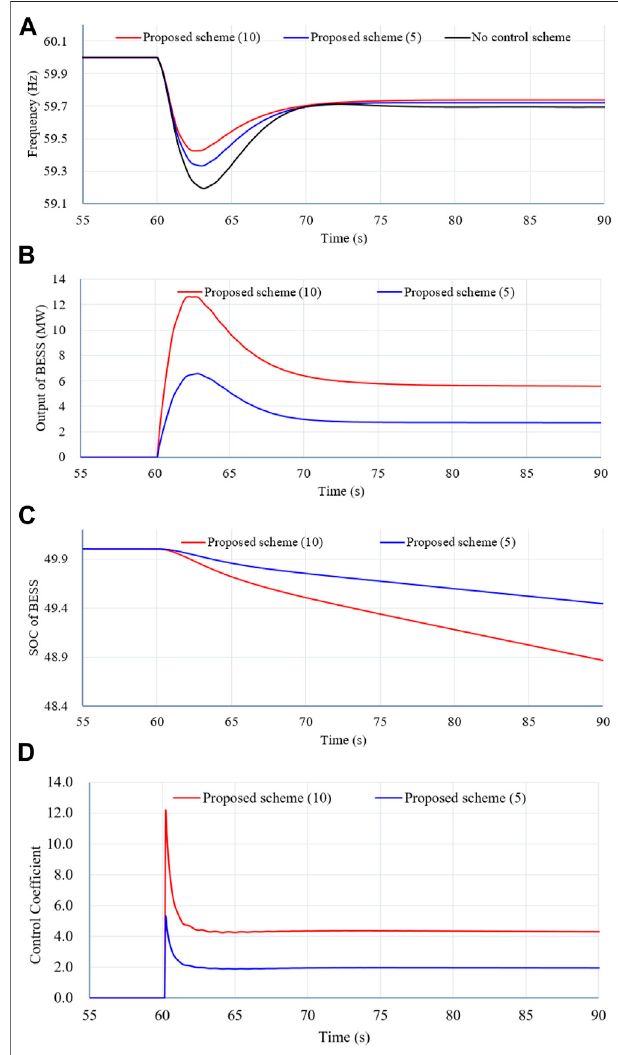
FIGURE 11 | Results for Case 3. (A) System frequency. (B) Output power of the BESS. (C) SOC of the BESS. (D) Control coef fi